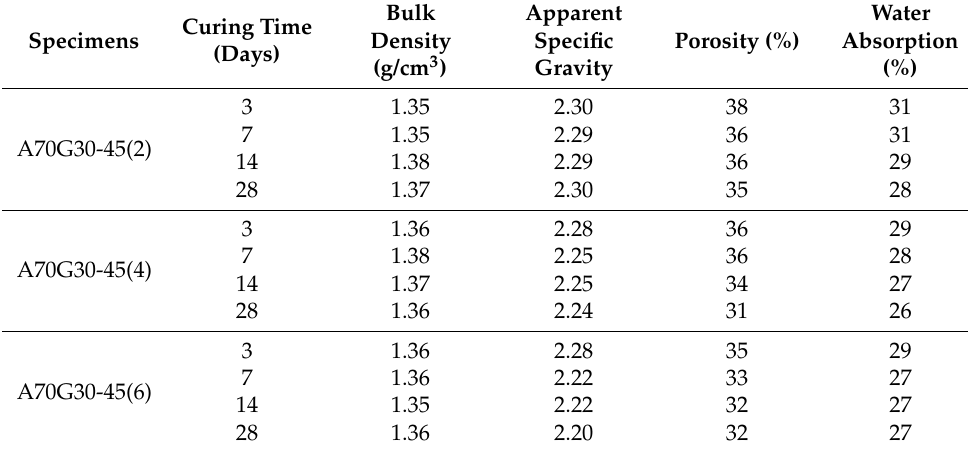
Table 7. The physical properties of AG geopolymers.